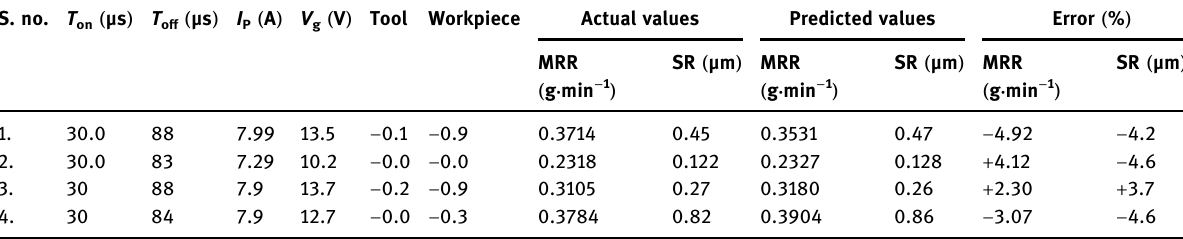
Table 8: Con fi rmation experiments and results